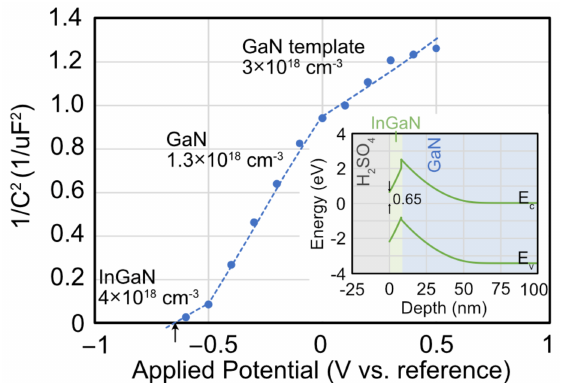
Figure 2. The inverse of the capacitance squared (1/C 2 ) versus applied potential with respect to the AgCl|Ag reference electrode is determined by impedance spectroscopy. The three fitted lines deter- mine the electron concentration in the InGaN, GaN, and GaN template layers. The data crosses the x-axis at − 0.65 V (arrow), which is the flat-band potential at the electrolyte/semiconductor interface. The inset shows the band diagram for the H 2 SO 4 /InGaN/GaN structure along the c -direction at equilibrium with zero applied potential. The y-axis is positioned, so the Fermi-energy level in the GaN template is at 0